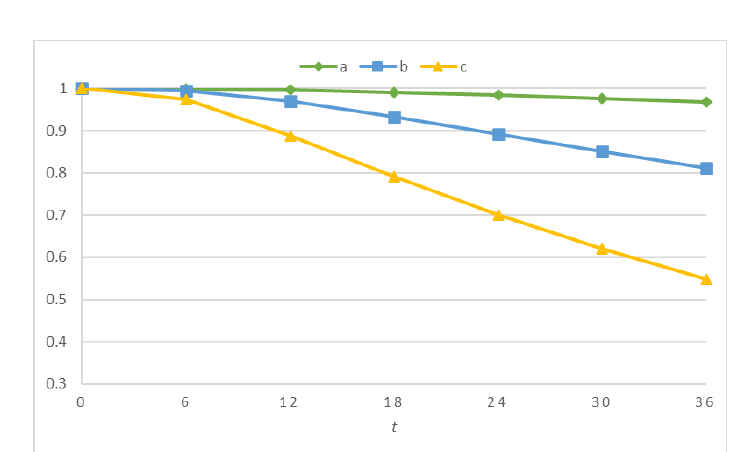
on the Bitcoin dependability. , 𝜆 01 12